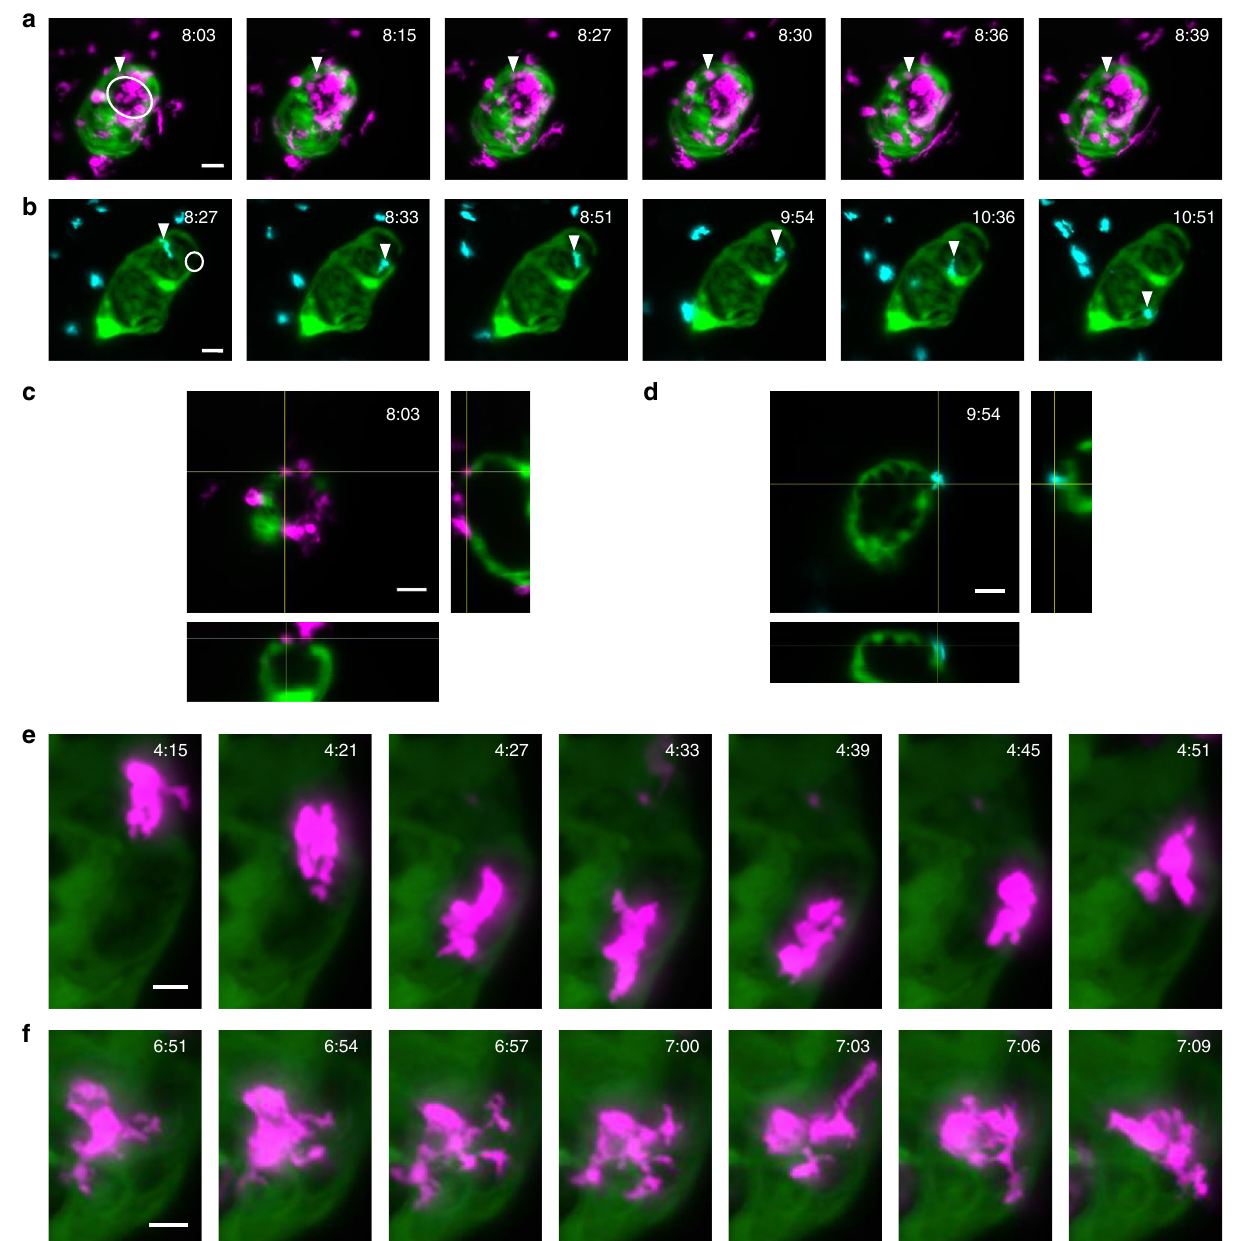
Fig. 4 Sustained beating-heart time-lapse imaging of immune cell responses to cardiac injury. a , b Sequence of MIPs (from Supplementary Videos 6 – 8) showing macrophages ( a magenta mpeg1 :mCherry) and neutrophils ( b cyan mpx :mCherry) migrating to, and interacting at, the laser wound site (white circle) on the ventricle ( myl7 :GFP, laser injury has bleached myocardial cells at the injury site). Arrowheads mark tracked immune cells interacting with the wound margins, changing shape and reverse migrating from the wound to the pericardium. c , d Orthogonal plane views co-localising the tracked macrophages ( c ) and neutrophils ( d ) on and within the myocardium at the wound site. e , f Individual macrophages are seen to undergo complex shape changes during migration. All timestamps show hours post injury (hpi). Scale bars: 30 μ m (10 μ m for e , f